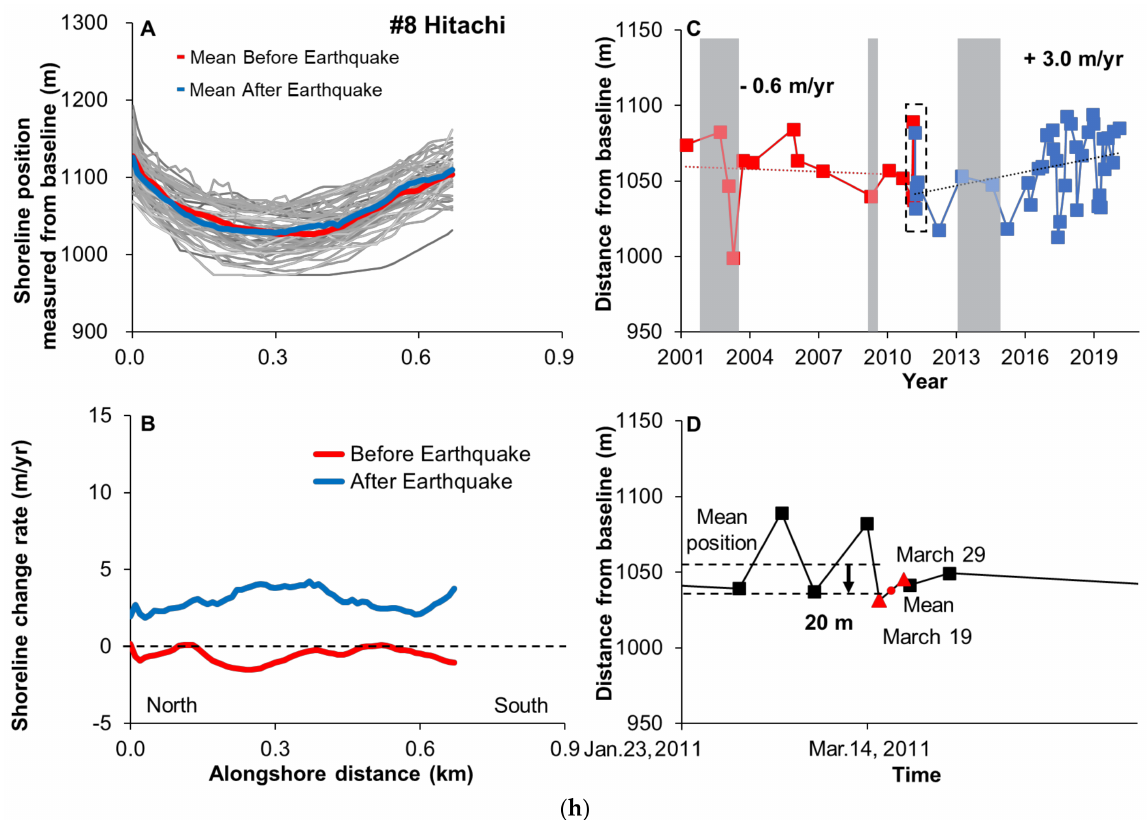
Figure 6. Variations of shoreline positions of the eight sandy beaches, from sub-figures ( a – h ). Panel A represents shoreline positions determined from the images. Panel B shows shoreline change rates based on linear regressions, for periods before and after the earthquake. Panel C shows temporal variation of mean shoreline position of the beach and shoreline change rates based on linear regressions of the periods before (red dotted line) and after (blue dotted line) the earthquake. Light blue stripes represent the periods recorded when strong typhoons occurred, as shown in the Figure 5. Panel D represents an enlarged view of the period shortly before and after the earthquake (January 2011–April 2011). Red triangles denote the data acquisitions taken shortly after the earthquake, and the red dot is their